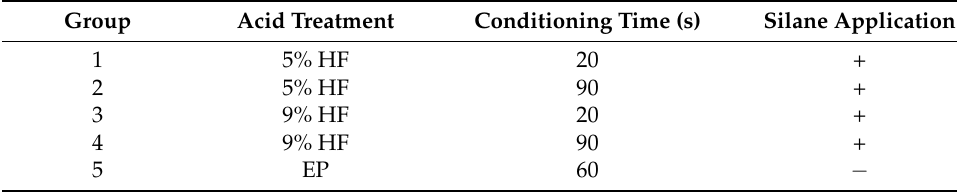
Table 1. The various surface treatments applied to the IPS e.max Press ingots. Group Acid Treatment Conditioning Time (s) Silane Application 1 5% HF 20